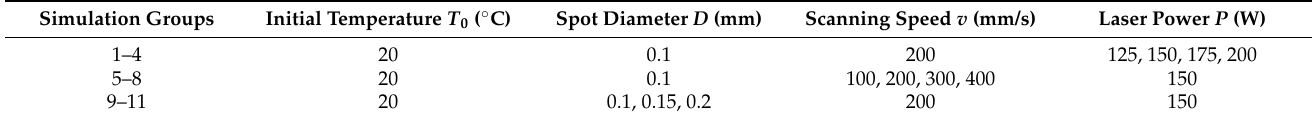
Table 2. The number of scanning is two with a zigzag scanning strategy in finite simulation. Table 2. Laser processing